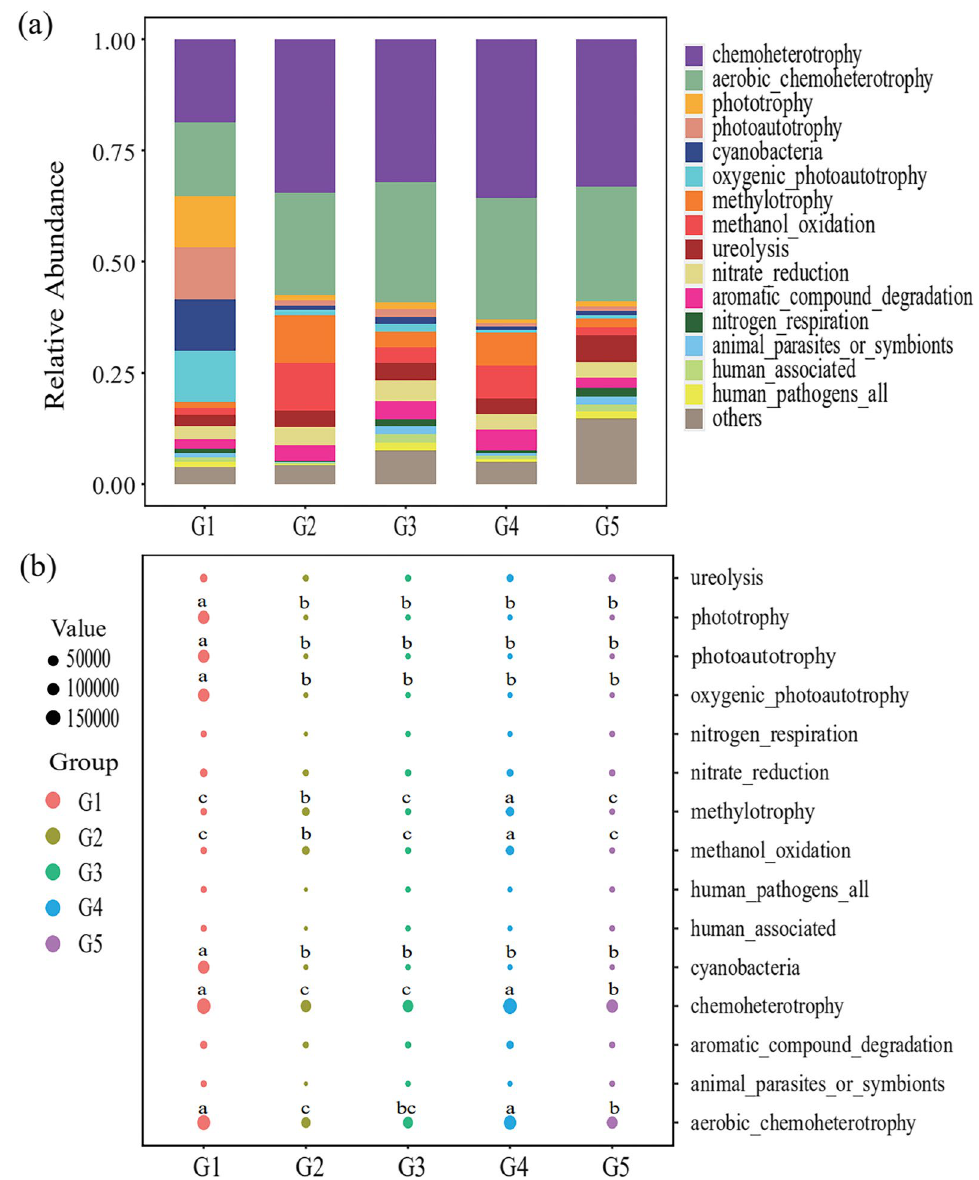
Fig. 6 Predicted functional profiles. a The relative abundance of the dominant predicted functions among five groups. b Bubble chart of the dominant predicted functional profiles of bacterial communities across five groups of plant species. The functional groups of bacteria were inferred using Tax4Fun. Dot size and color indicate the absolute abundance of predicted functions. Different lowercase letters above the boxes represent significant differences between different plant species based on one-way ANOVA with LSD multiple comparisons ( P <